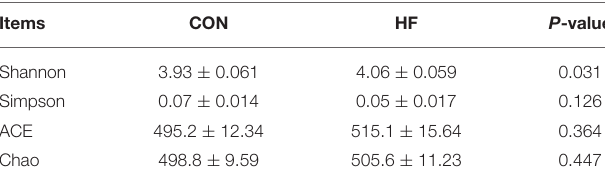
TABLE 5 | Effects of honeycomb flavonoids (0.5% of HF) on α -diversity of cecal contents bacterial communities ( n = 8). Items